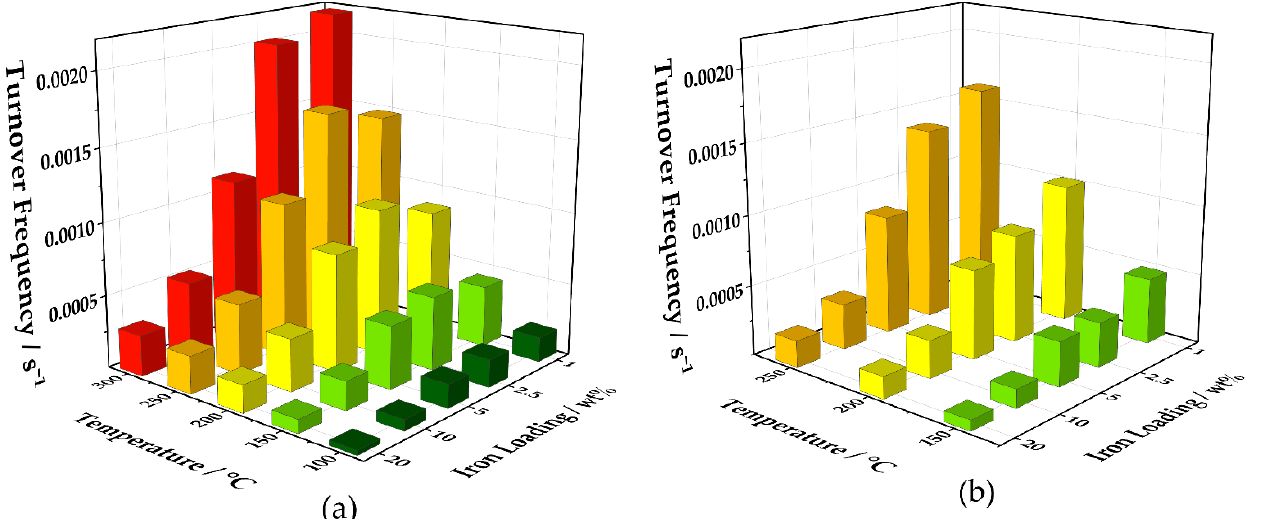
Figure 13. Three-dimensional visualization of the turnover frequencies of Fe01 to Fe20 calculated from the values obtained by the measurements with continuous heating ( a ) and at constant temperatures ( b ).